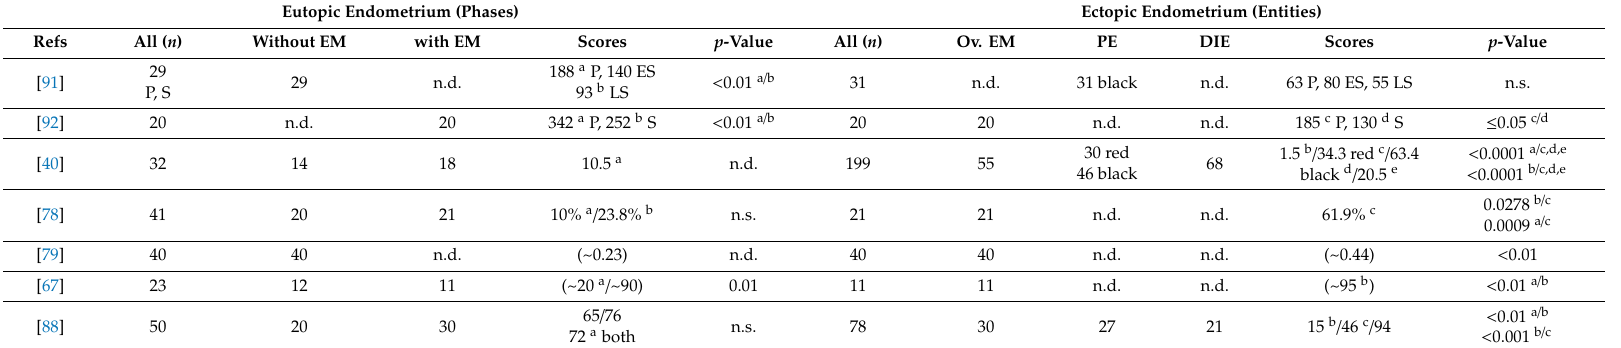
Table 6. Immunohistochemistry of vimentin in eutopic and ectopic